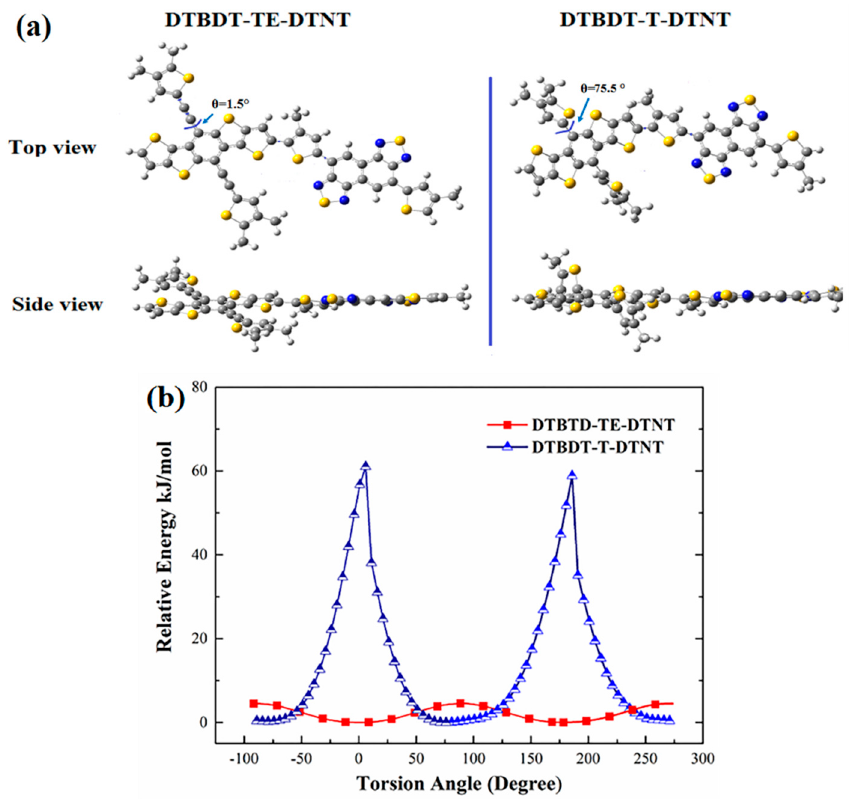
Figure 9. ( a ) Optimized geometries of the models for DTBDT-TE-DTNT and DTBDT-T-DTNT by DFT at the B3LYP/6-31G*; ( b ) relative energy at different torsion angles.